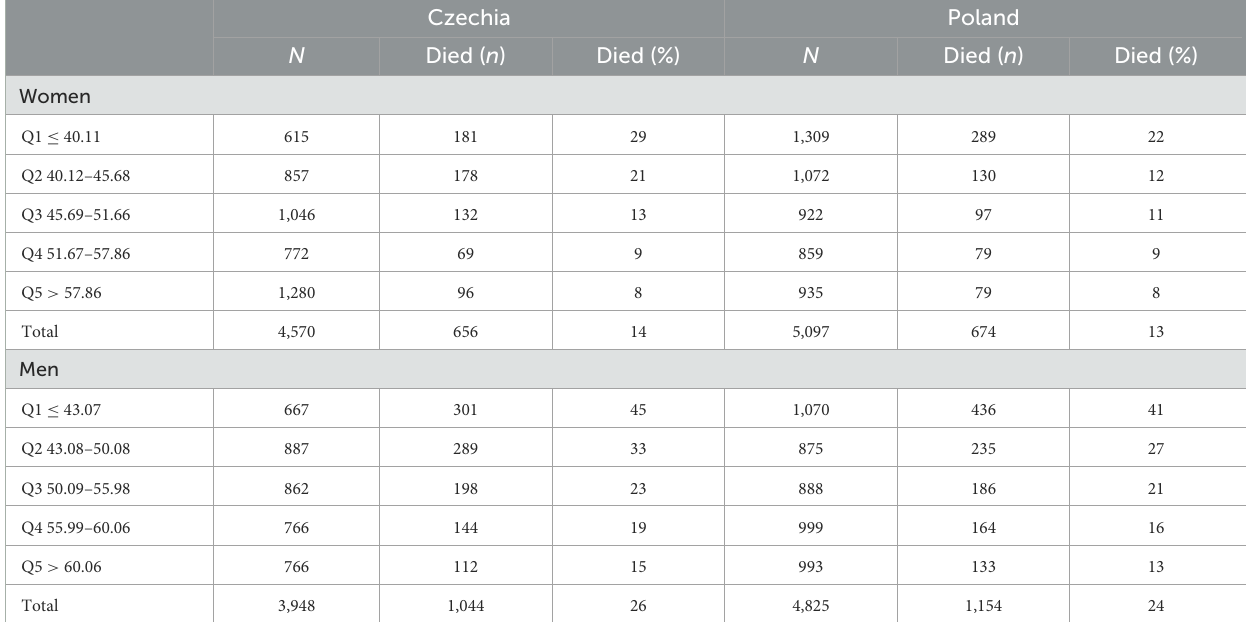
TABLE 2 Proportions of deaths by quintiles of ATHLOS Healthy Aging Scale score, country and gender. Czechia